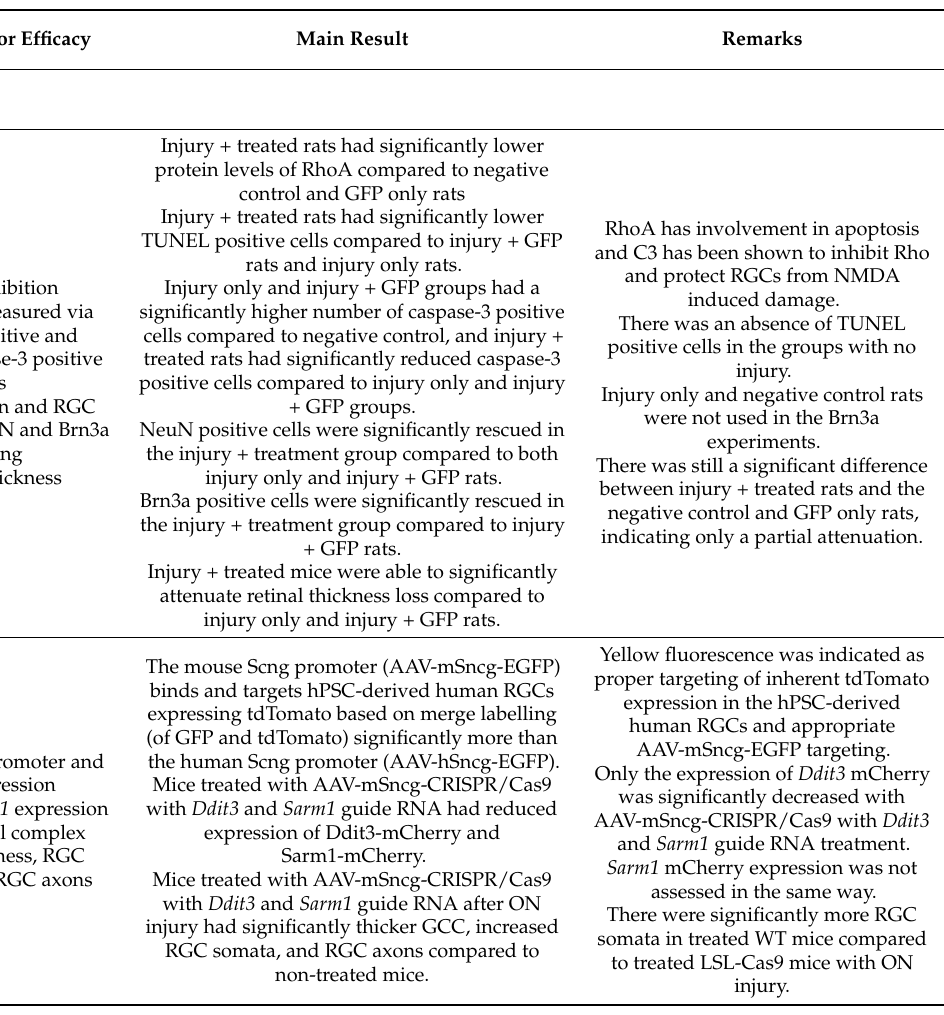
Table 4. Summary of in vivo studies utilizing an AAV vector encoding different genes as gene